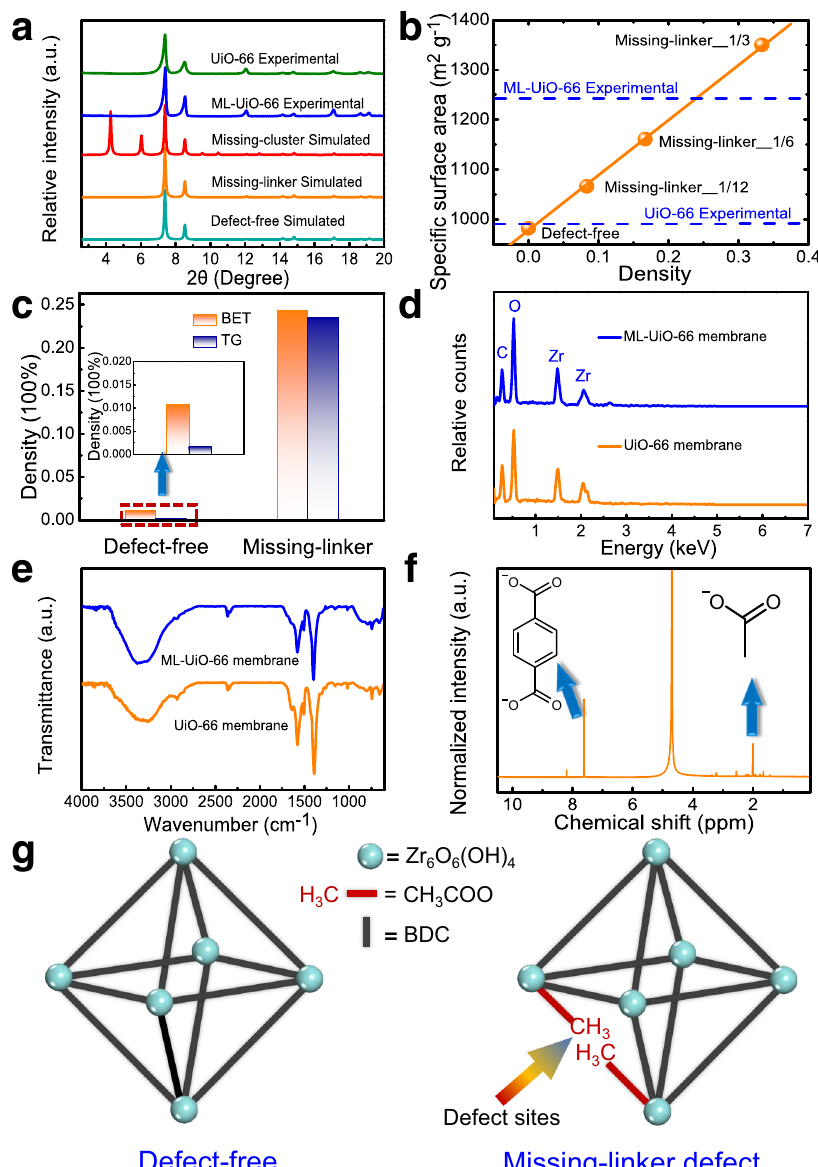
Fig. 4 Experimental characterization of missing-linker defects in ML-UiO-66 structure. a Low-angle (2.6 − 20°, λ = 1.541Å) experimental and simulated XRD patterns of UiO-66 structures with different intra-crystalline defects. b Simulated and experimental relationship between speci fi c surface area and missing-linker defect density. c Defect density comparison between UiO-66 and ML-UiO-66 powders determined by Brunner − Emmet − Teller (BET) and thermogravimetric (TG) results (Supplementary Figs. 24, 25). d EDS spectra of UiO-66 and ML-UiO-66 membrane surface. e Attenuated total re fl ection- Fourier transform infrared spectroscopy (ATR-FTIR) spectra of UiO-66 and ML-UiO-66 membrane. f Liquid 1 H Nuclear magnetic resonance (NMR) spectrum of ML-UiO-66 powder. g Structural representations of UiO-66 (defect-free) and ML-UiO-66 (missing-linker